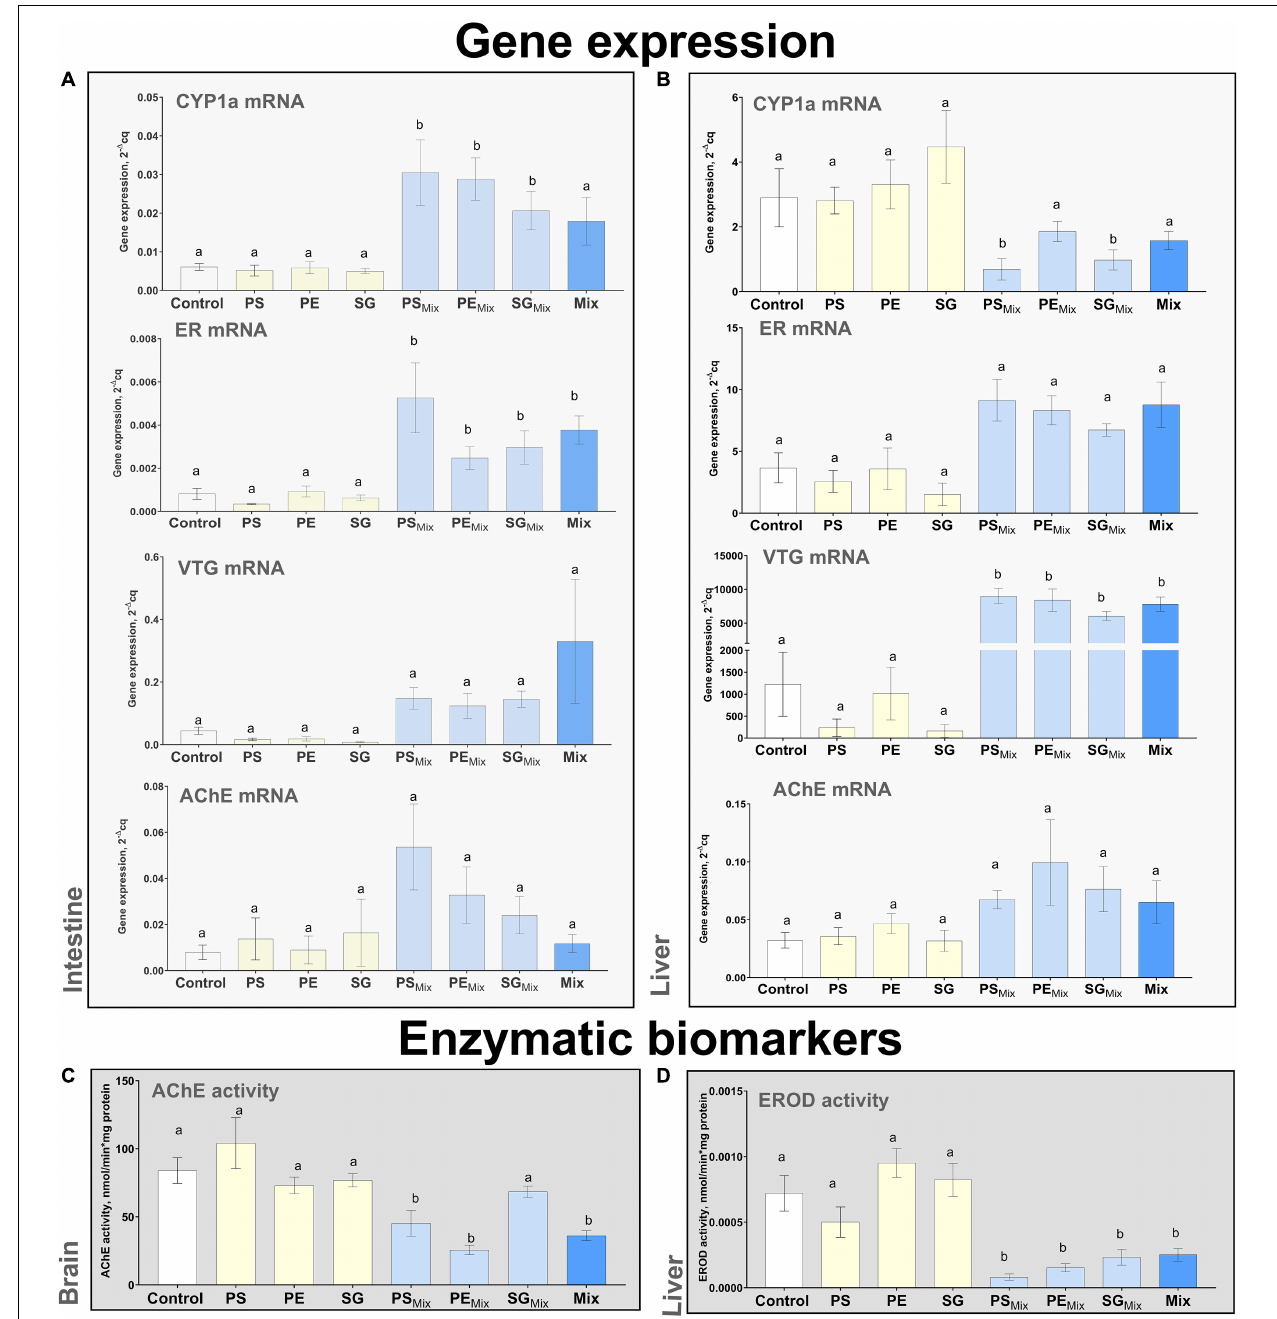
FIGURE 3 | Biomarker responses: gene expression (A,B) and enzymatic activities (C,D) in different organs: intestine (A) , liver (B,D) and brain (C) . Data expressed as means ± SE, N = 6. Different letters indicate statistical differences between the control and exposure treatments (one-way ANOVA, post hoc Dunnett test, p < 0.05).